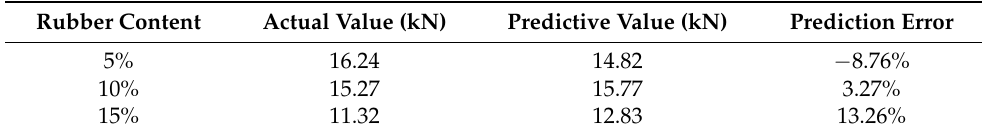
Table 9. RMS (6) single-parameter neural network prediction results.